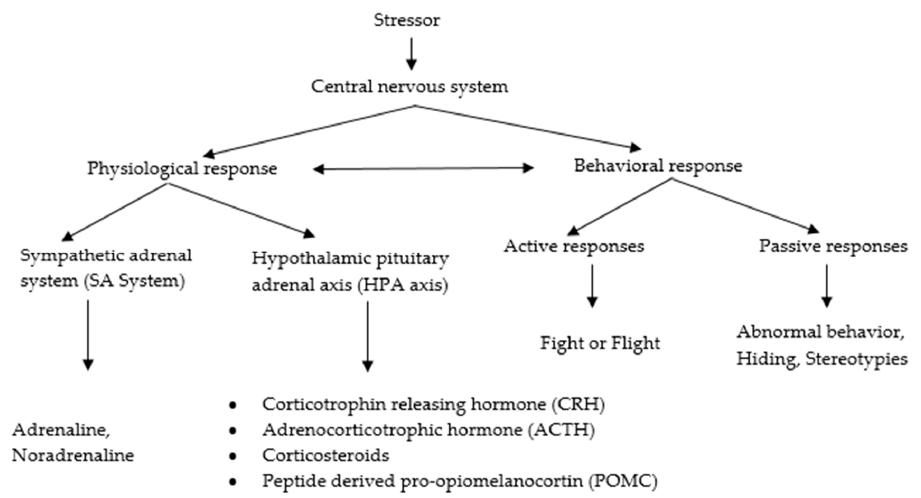
Figure 2. Scheme of overall responses to stress.